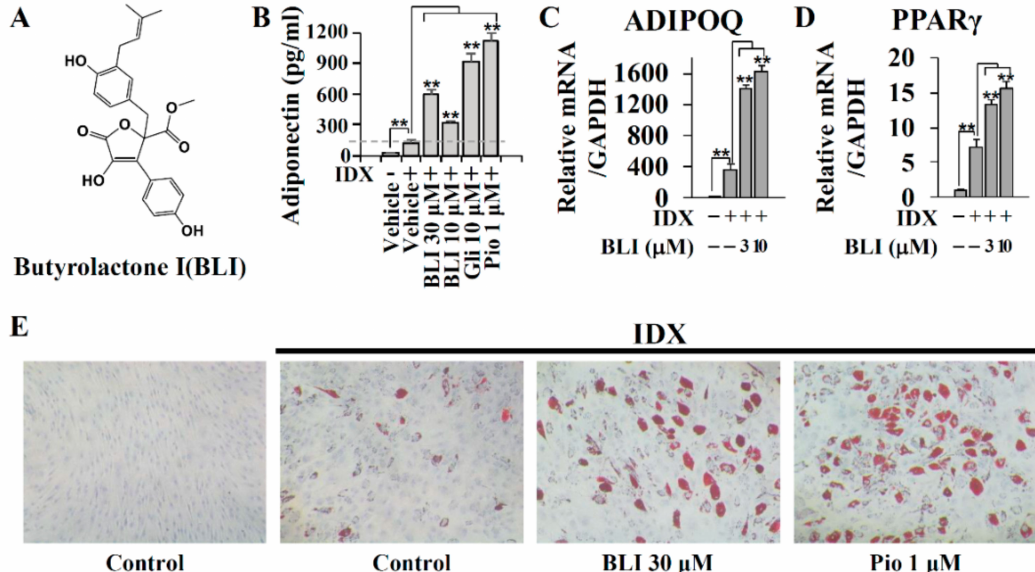
Figure 1. The adiponectin production-enhancing activity of butyrolactone I (BLI) during adipogenesis in human bone marrow-derived mesenchymal stem cells (hBM-MSCs). ( A ) The structure of butyrolactone I isolated from the marine-derived Aspergillus terreus . ( B ) Butyrolactone I was co-treated with the insulin (IDX) medium to induce adipogenesis in hBM-MSCs. On the fifth day of the adipogenic di ff erentiation, cell culture supernatants were collected and the adiponectin production-enhancing activity was measured by ELISA. Glibenclamide (gli) and pioglitazone (pio) were used as positive controls. ( C and D ) In addition, on day 3, the total RNA was extracted and Q-RT-PCR was performed for adiponectin ( ADIPOQ ) and PPAR γ . GAPDH was used as a reference control. ( E ) On the seventh day of adipogenic di ff erentiation, ORO staining was performed to evaluate the lipid droplets formation. Values represent means ± standard deviation (SD, n = 3); * p ≤ 0.05, ** p ≤